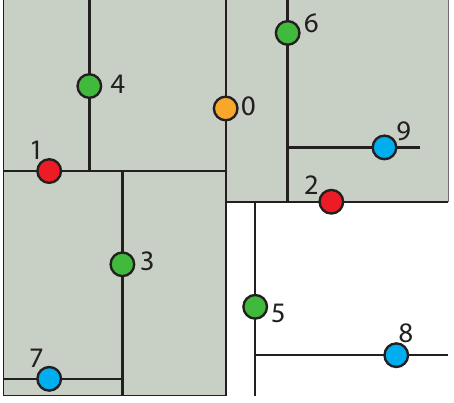
Figure 9. The top half-space in the right sub-tree is ignored when searching Node 8.